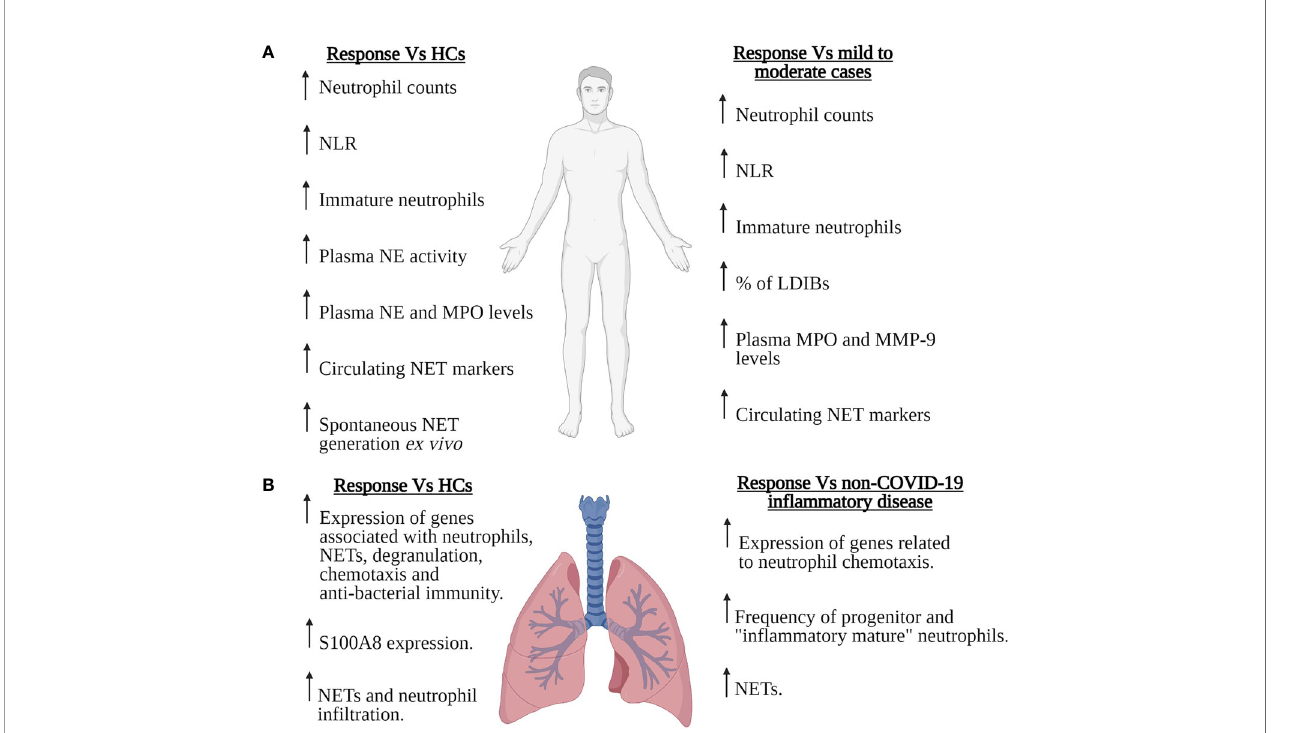
FIGURE 1 | Neutrophils in severe COVID-19. Summary of the SARS-CoV-2-induced changes that have been reported for the number, composition and/or function of circulating (A) or pulmonary (B) neutrophils in patients with severe COVID-19. Features of the neutrophil response of severe COVID-19 patients are compared to those of healthy controls (HCs), patients with mild-to-moderate COVID-19 or patients with non-COVID-19 in fl ammatory disease. For the pulmonary neutrophil response summarised in (B) , data was derived from the analysis of bronchoalveolar lavage fl uid or post-mortem lung tissue sections. LDIBs, Low density in fl ammatory band cells; MMP-9, Matrix metalloproteinase-9; MPO, Myeloperoxidase; NE, Neutrophil elastase; NETs, Neutrophil extracellular traps; NLR, Neutrophil to lymphocyte ratio. Figure created with